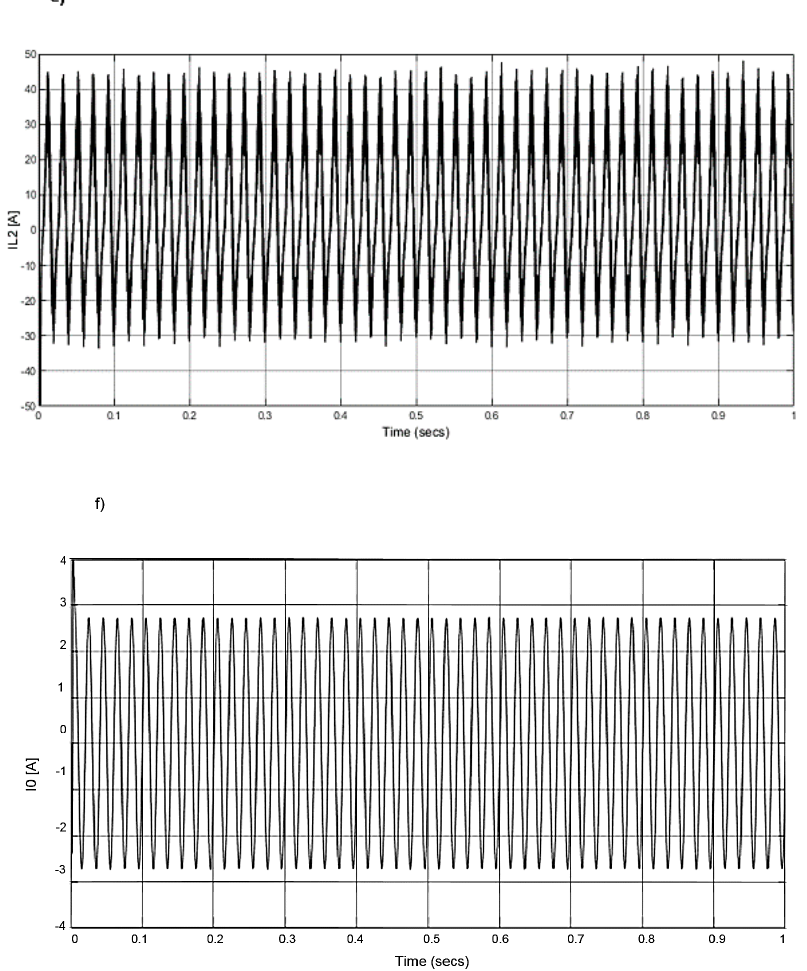
Figure A1. The performances (courses of voltages V 0 , V 1 , V 2 , and currents I L1 , I L2 , I 0 versus time) for the Li-ion battery cooperating with the boost inverter. ( a ) V 0 ; ( b ) V 1 ; ( c ) V 2 ; ( d ) I L1 ; ( e ) I L2 ; ( f ) I 0 .